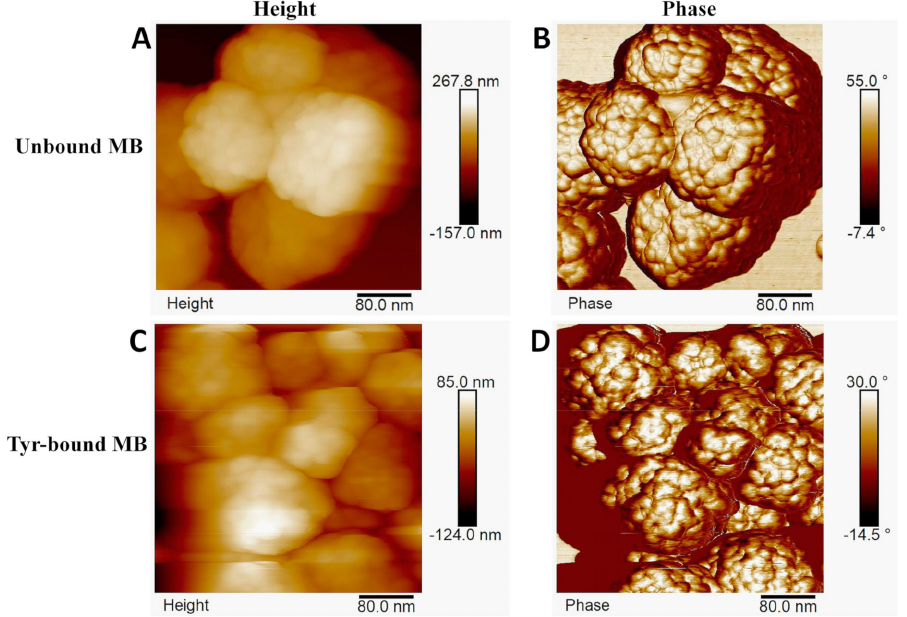
Figure 5. Height and phase modalities in AFM. Although the images show that Tyr-bound MB had higher aggregation sizes than bare beads due to using Poly-L-lysine-coated substrates to attach the negatively charged, hydrophilic MB particles, this was not so during experimentation. ( A ) shows the unbound MB in the height modality. ( B ) displays the unbound MB in the phase modality where you can see the fine details of the nanostructures on the hydrophilic layer of the MB, which cannot be detected in the geographical shape detection of the height modality. ( C ) displays the Tyr-bound MB in the height modality. ( D ) displays the Tyr-bound MB in the phase